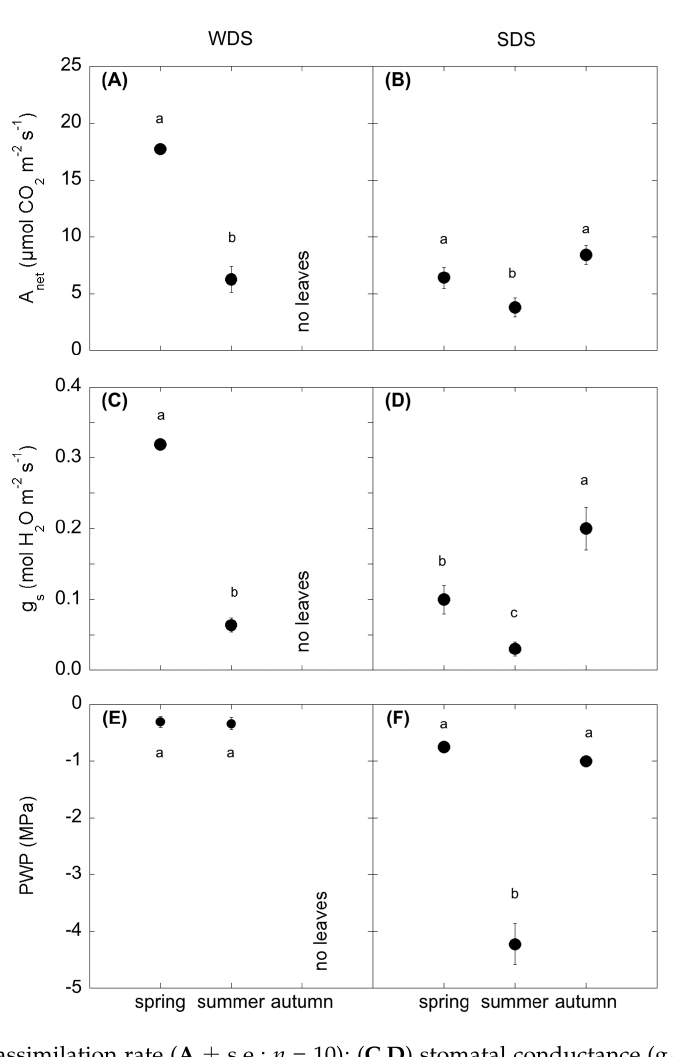
Figure 1. ( A , B ) assimilation rate ( A ± s.e.; n = 10); ( C , D ) stomatal conductance (g s ± s.e.; n = 10,); ( E , F ) pre-dawn water potential (PWP ± s.e.; n = 10) in the winter deciduous (WDS, left panels, A , C , E ) and summer deciduous (SDS, right panels, B , D , F ) sites. Gas exchange was not measured in autumn in the WDS site because of the leaf fall. Lowercase letters show significant differences among the seasons at p < 0.05.